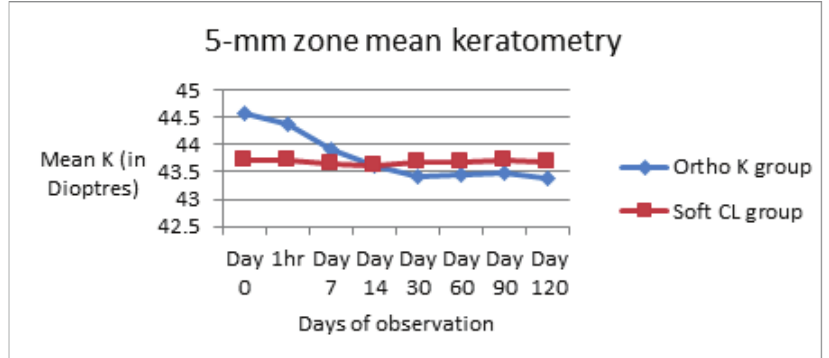
Figure 4. Change in mean keratometry in both groups in 5-mm zone. CL, contact lens; K, keratometry; Ortho K, Orthokeratology.